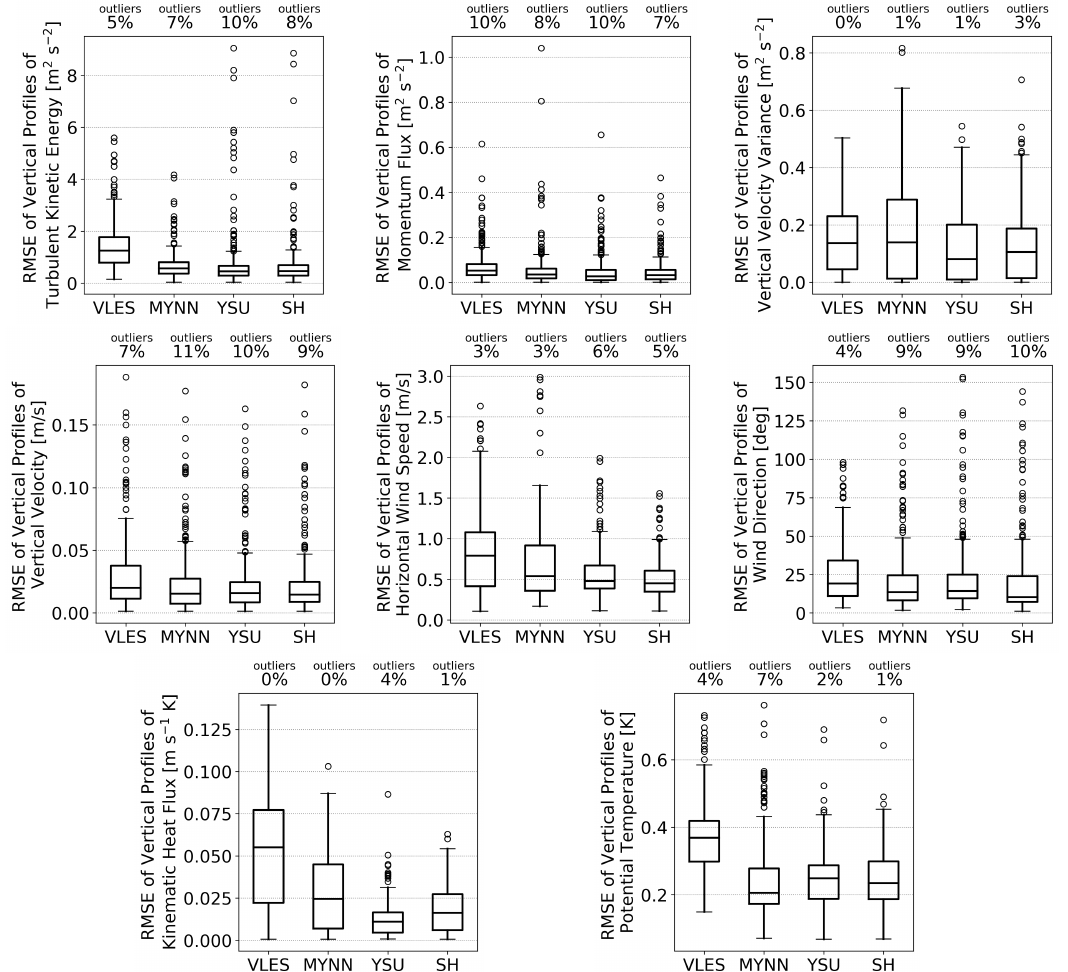
Figure 8. Distribution of RMSE time series computed from vertical profiles of horizontally averaged turbulent kinetic energy, momentum flux, vertical velocity variance, vertical velocity, horizontal wind speed and direction, heat flux and potential temperature. Whisker plots show 25th, 50th and 75th quantiles. The circles extending out from the whisker plots represent the distribution outliers. The percent values in each figure quantify the percentage of outliers rounded to the nearest